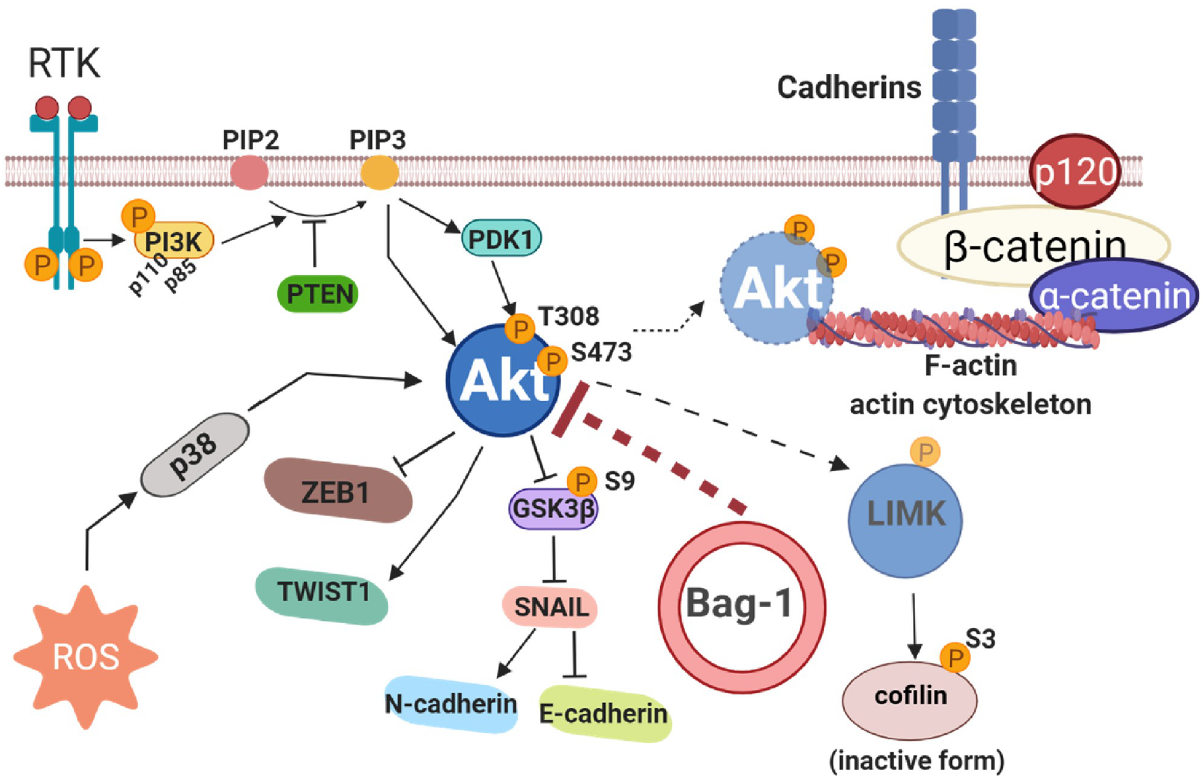
Fig 6. The schematic overview of Akt-mediated actin reorganization in Bag-1 deficiency. Akt is the main regulator of this signaling route, which was activated by ROS generation in Bag-1 KO MCF-7 cells and triggered several downstream mediators to enhance mesenchymal characteristics and cytoskeleton rearrangement. The expression profile of Bag-1 is important for the Akt-mediated cytoskeleton reorganization. This figure was created with BioRender.com.